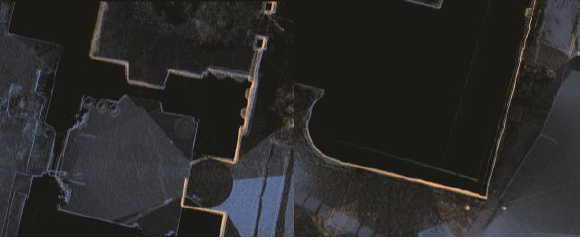
Figure 5 . Detail of the correspondence in the alignment between TLS (blue) and MLS (pink) point